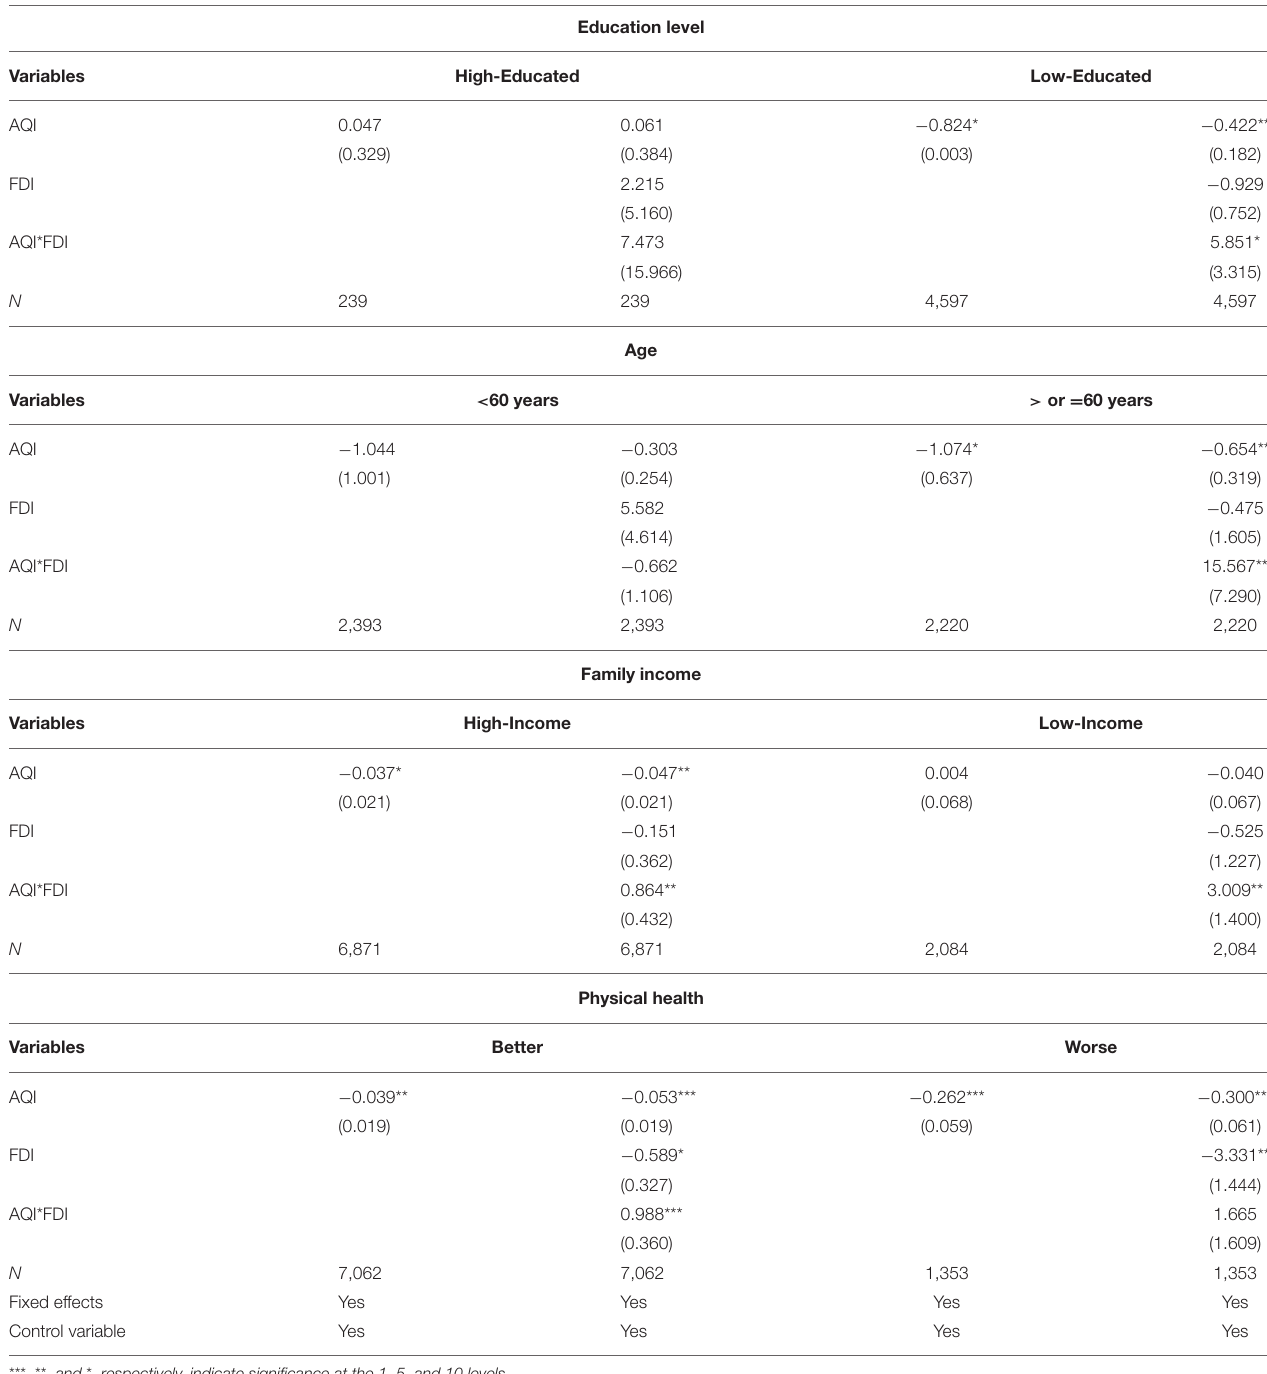
TABLE 8 | Heterogeneity based on education, age, income, and changes of physical